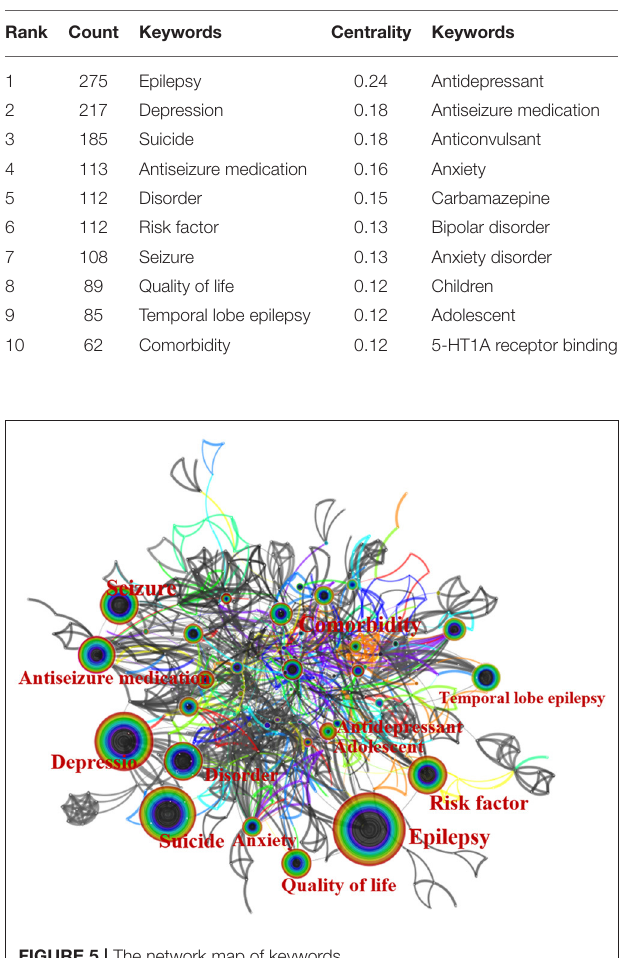
FIGURE 5 | The network map of keywords.